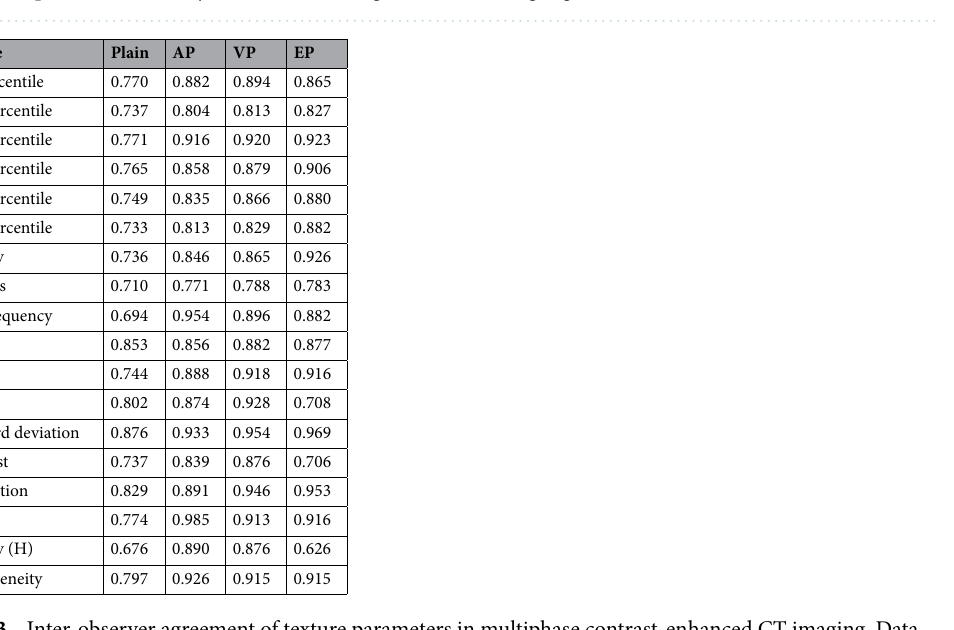
Figure 1. Representative cases in the portal venous phase to show texture differences between different isocitrate dehydrogenase (IDH) states. ( A ) Typical case in an IDH wild-type group; ( B ) histogram plot of the intensity values from the region of interest highlighted in ( A ). ( C ) Typical case in an IDH mutation group; ( D ) histogram plot of the intensity values from the region of interest highlighted in ( C ).